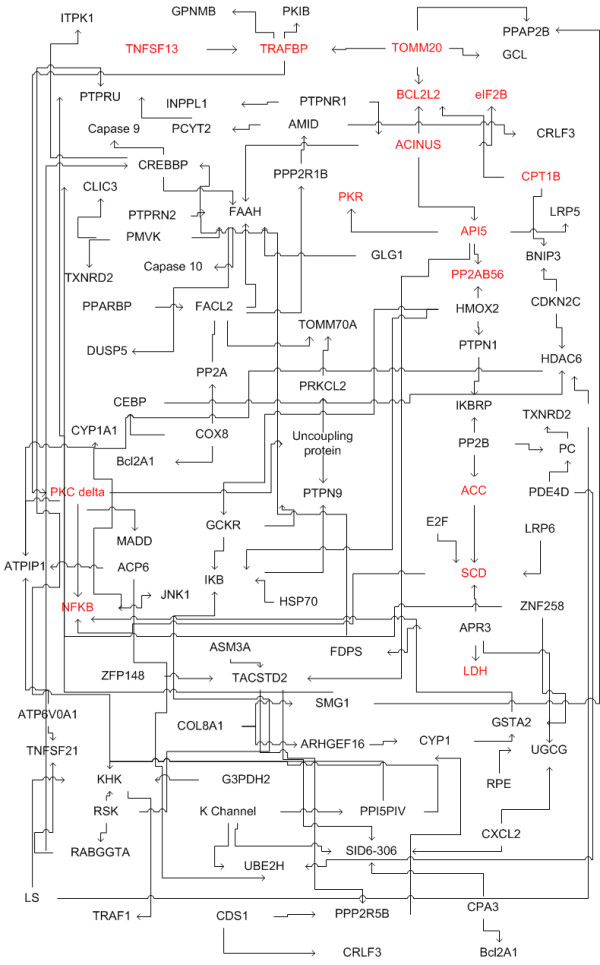
Network reconstructed with constraints based algorithm. GA/PLS and ICA selected the relevant genes, and BN analysis reconstructed the network using the selected subset of genes. The network provides an overview of the factors and pathways involved in regulating cytotoxicity. The nodes discussed in the paper are highlighted in red. Microsoft Visio was used to generate the Figure.